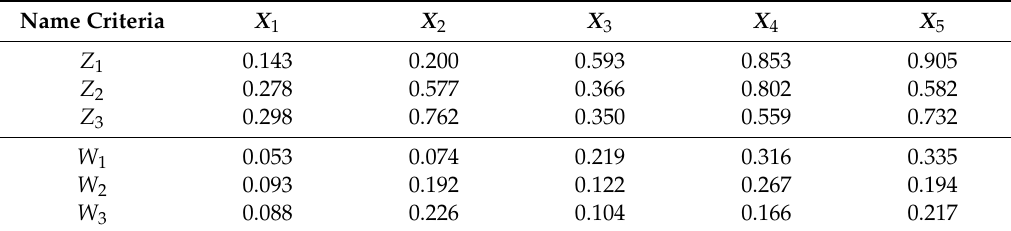
Table 8. Function of postsynaptic potential of neurons of the second and third